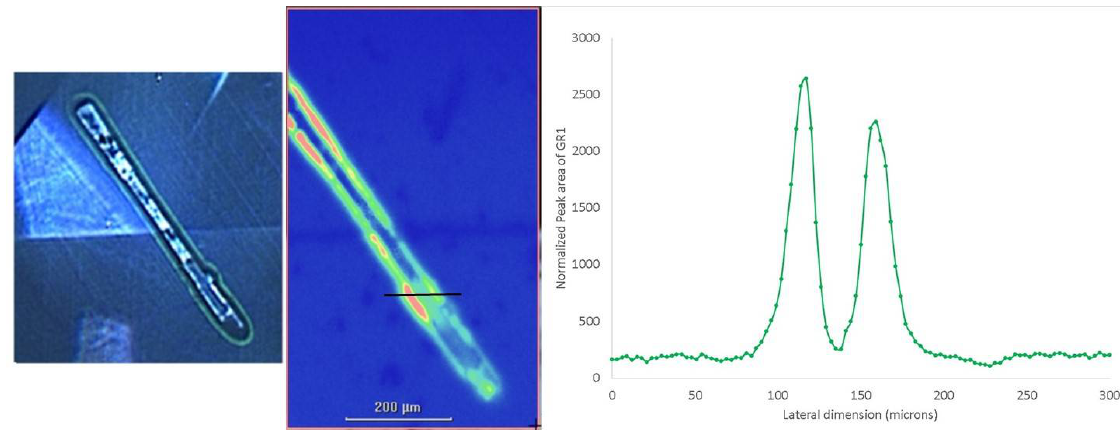
Figure 9. ( Left ) DiamondView fluorescence image showed interesting green fluorescence around the cavities on the crown facet of a 0.70 ct E-color diamond. The green fluorescent haloes were created by radioactive fluids ( Center ). Subsequent PL mapping with 532 nm excitation showed that high amounts of radiation brought about a number of localized changes in the diamond surrounding the cavities. ( Right ) A line scan (indicated by a black line in the central image) shows the normalized peak intensity for the GR1 from the PL map, collected at 3 µ m intervals [34].